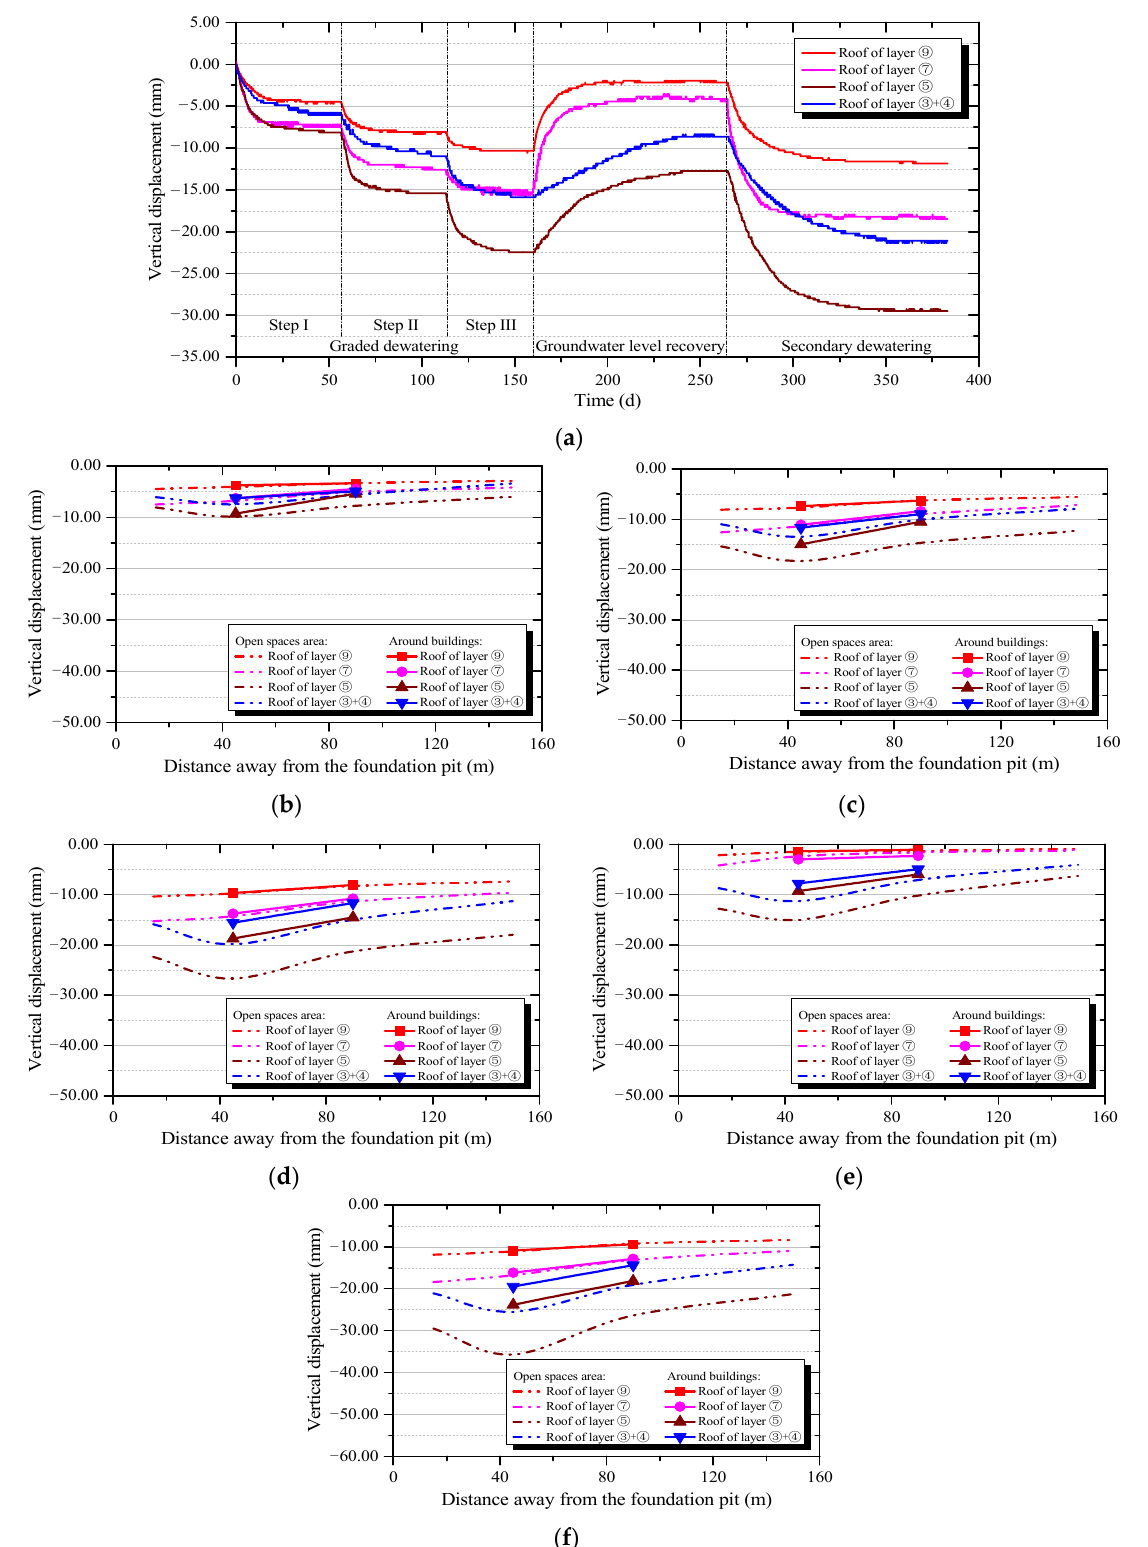
Figure 4. Groundwater level changes in strata at JF–1 (15.0 m away from deep excavation).